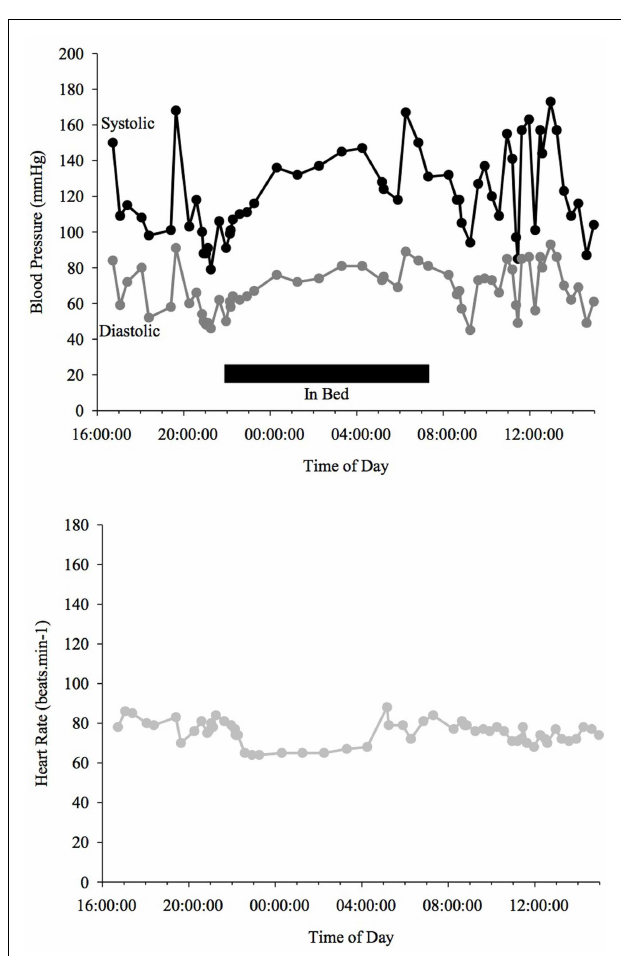
FIGURE 4 | Blood Pressure (upper line systolic, lower line diastolic) and heart rate profiles during 24hABPM of a PD patient with a reversed BP profile. BP increases at night time in contrast to a dipper. Black bar indicates